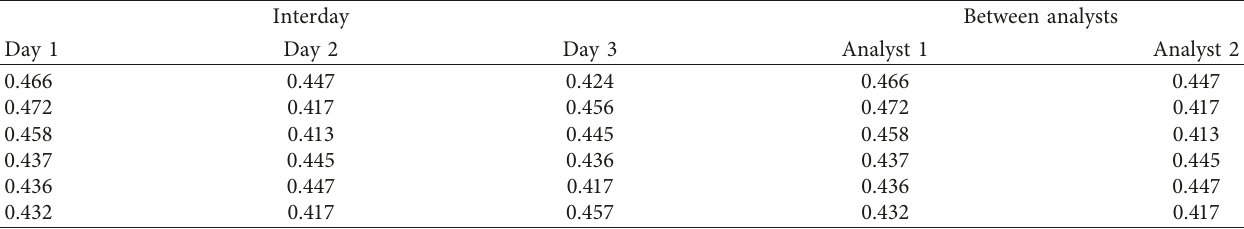
Table 2: Absorbances obtained for the evaluation of interday and between analysts precision to validate the spectrophotometric method in the mid-infrared region for the analysis of amoxicillin capsules.